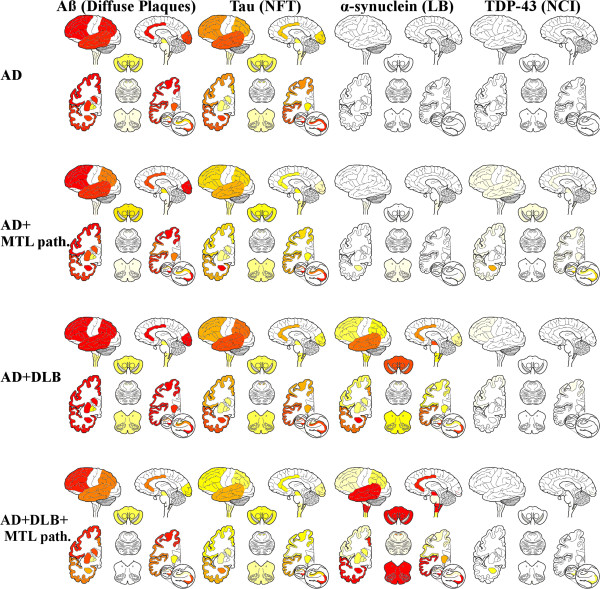
Heatmaps summarizing the semiquantitative neuropathological grading (from left to right: diffuse amyloid plaques, neurofibrillary tangles (NFT), Lewy bodies (LB) and neuronal citoplasmatic TDP-immunoreactive inclusions (NCI)) for the different neuropathologic diagnostic groups (from top to bottom: AD, AD + MTL pathology, AD + DLB, AD + DLB + MTL pathology and DLB + MTL pathology).